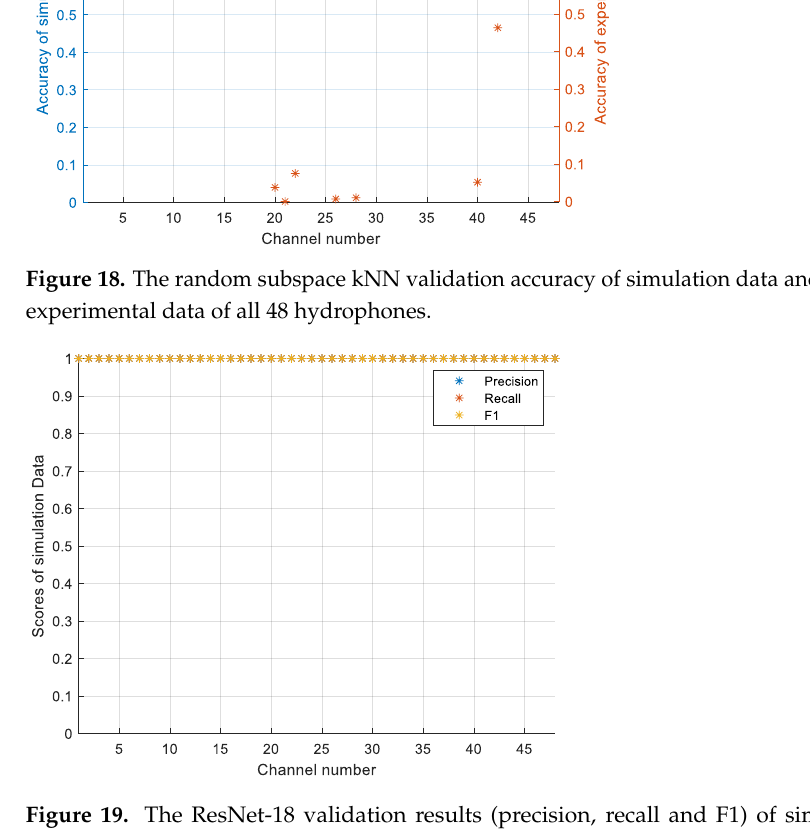
Figure 20. The ResNet-18 validation accuracy of simulation data and testing accuracy of experi- mental data of all 48 hydrophones. 5.4.4. Comparison The performances of all 48 hydrophones of the VLA using the three machine learning methods are analyzed and compared. The lists of hydrophones that fail to reach the threshold of 0.9 are shown in Table 3. Table 3. Lists of hydrophones failing to reach the threshold of 0.9 using three kinds of machine learning methods (kNN, random subspace kNN and ResNet-18). Machine Learning Method